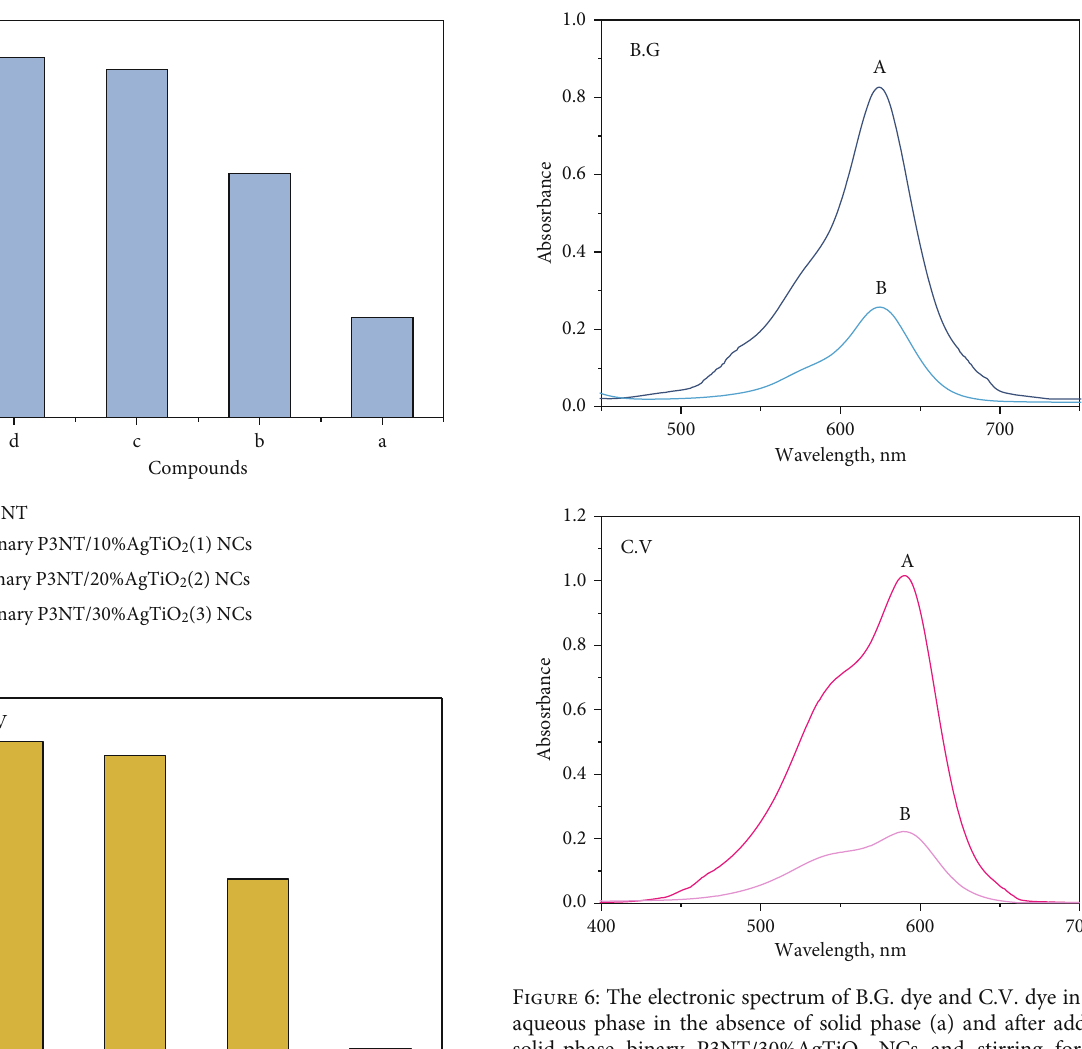
NCs and stirring for 75 2